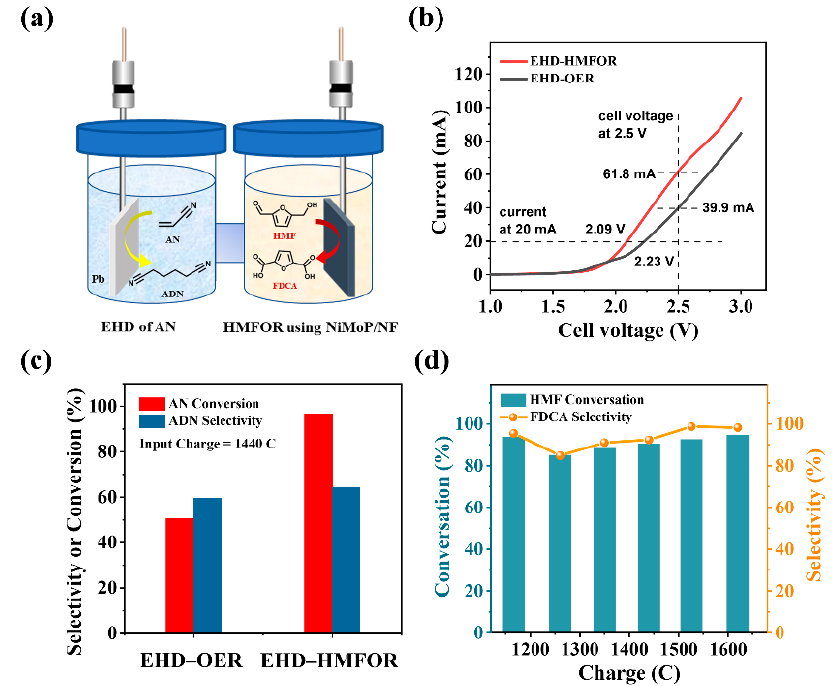
Figure 7. ( a ) Diagram of a paired electrolysis system in a two-electrode H-type cell; ( b ) LSV (10 mV · s − 1 ) of the ANEHD–OER and ANEHD–HMFOR systems in 1.0 M KOH with 10 mM HMF and 8 wt% AN; ( c ) ADN selectivity and AN conversion for unpaired and paired systems. Charge passed is 1440 C in each reaction; ( d ) the results of an anode in a paired electrolysis system. The current density can be used to control the two half reactions in a paired system